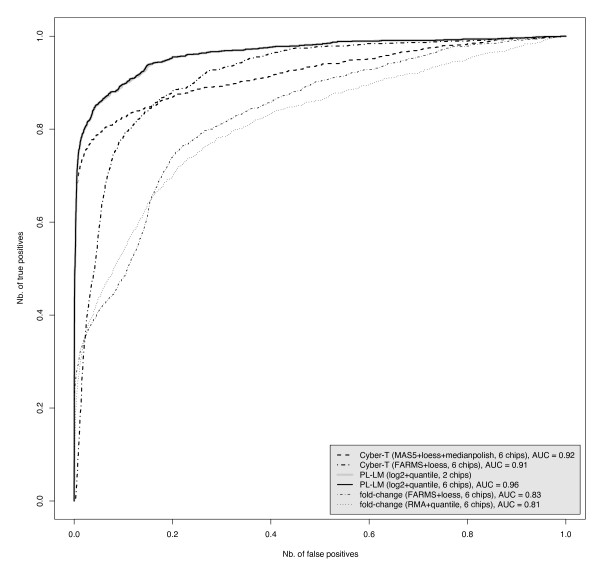
ROC curves comparing methods on the Choe et al. dataset. Probe-sets with a spiked to control concentration ratio above or equal to 1.2 were considered as DEGs to compute these curves, resulting in 1,326 spiked probe-sets to identify among a total of 14,010. The fold-change applied after RMA summaries and quantile normalization is shown as a baseline for comparison since it is a simple and frequently used method. Nine shaded curves, representing the results from applying the PL-LM method to all combinations of two arrays (one control vs. one spike), are falling directly under the PL-LM (on all replicates) curve (black line). For all methods, the area under the curve (AUC) is reported as a quantitative measure of both sensitivity and specificity.